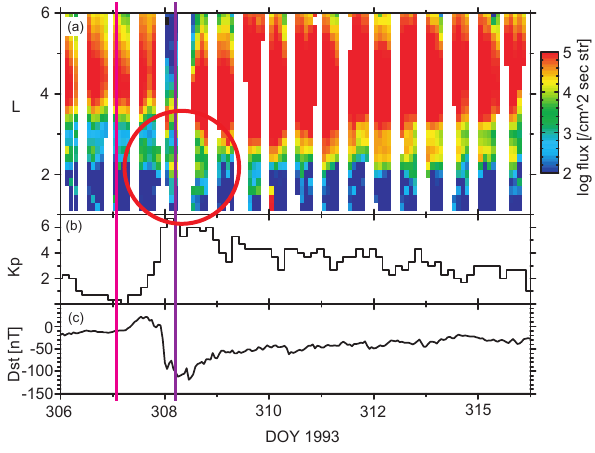
Fig. 3. Power spectral density of plasma waves observed by the Akebono satellite during a magnetic quiet time on day 307 of 1993. The solid line shows the local electron gyrofrequency. The top and middle panels exhibit the wave spectral electric field intensity by the PWS and the VLF instruments. The bottom panel indicates the wave spectral magnetic field intensity by the VLF/Akebono.